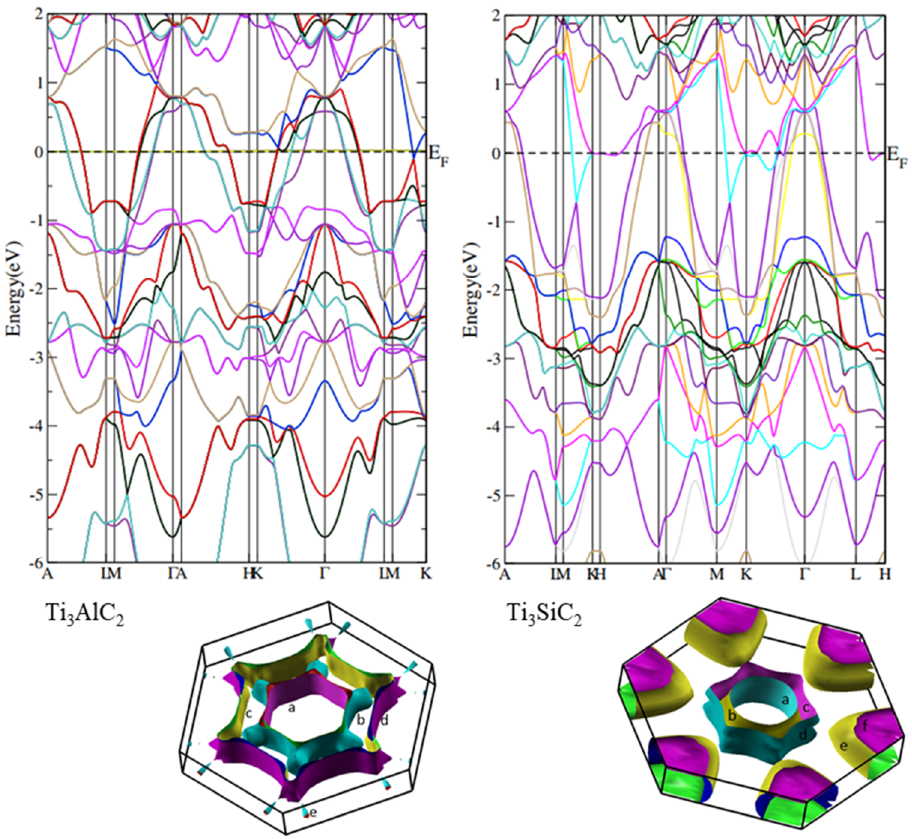
Figure 11. Band structures and Fermi surfaces of Ti 3 AlC 2 (left) and Ti 3 SiC 2 (right) for different bands. Vertical direction corresponds to the <001> axis in the reciprocal lattice.